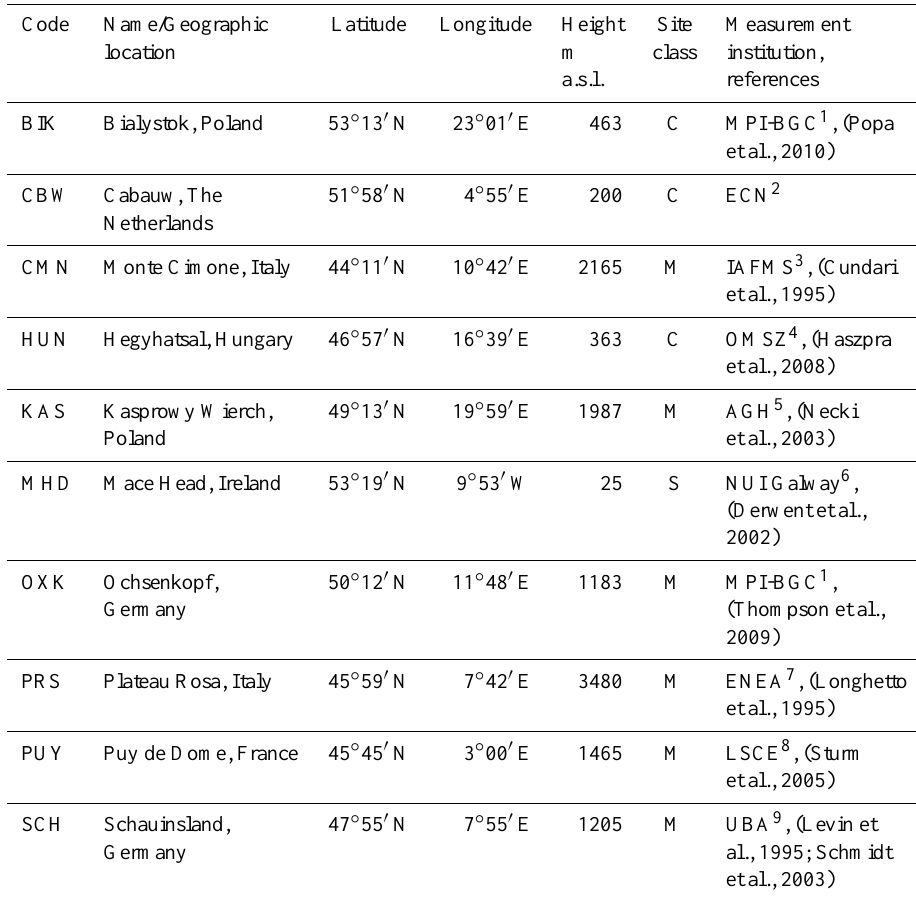
Table 1. Sites with the CO 2 concentration measurements for the validation of TM3 and TM3-STILT models.